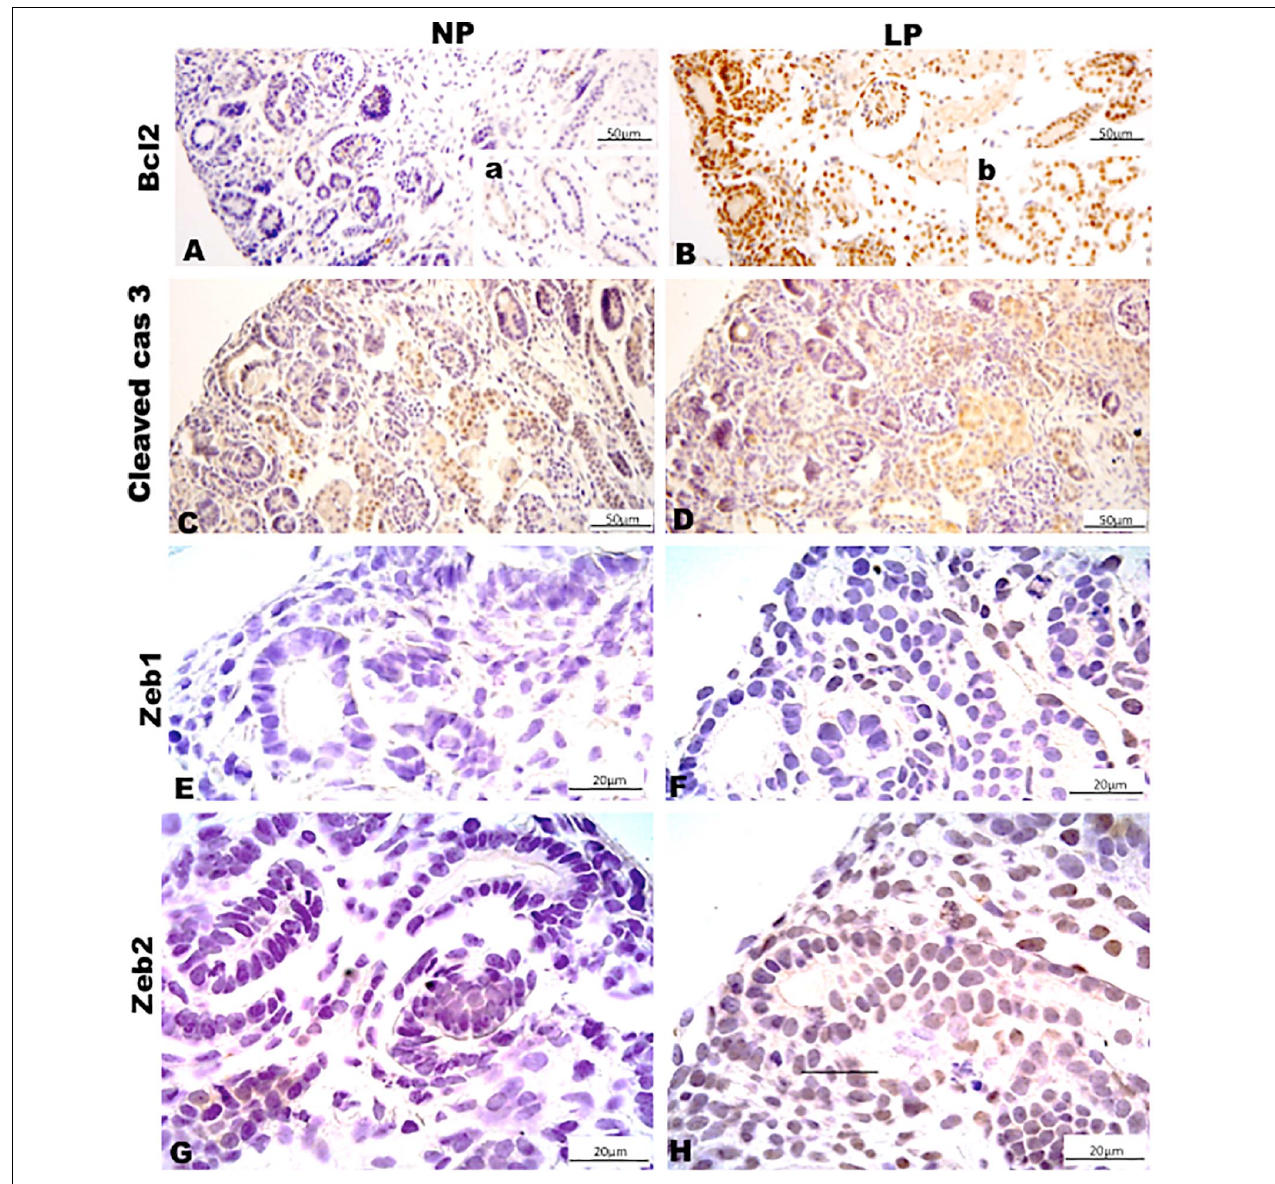
FIGURE 8 | Immunoperoxidase in kidneys of 21GD rats for (A,B) Bcl2, (C,D) cleaved cas 3, (E,F) Zeb1, and (G,H) Zeb2 for the NP (A,C,E,G) and LP (B,D,F,H) groups. The inserts represent the medullar